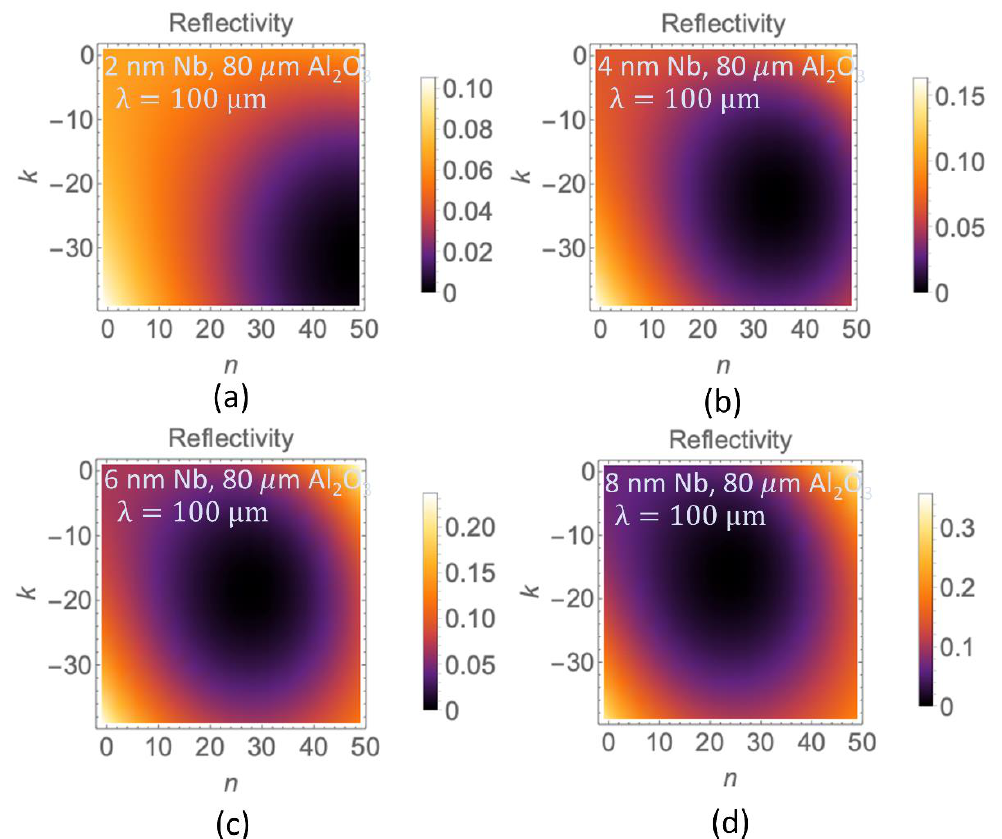
Figure 6. The dependence of the reflectivity on optical parameters n and k calculated at film thickness d 1 and light wavelength λ = 100 µ m corresponding to perfect impedance matching condition. Black / dark purple regions correspond to 100% anti-reflection. The Nb nano-film thicknesses were ( a ) 2 nm, ( b ) 4 nm, ( c ) 6 nm and ( d ) 8 nm.